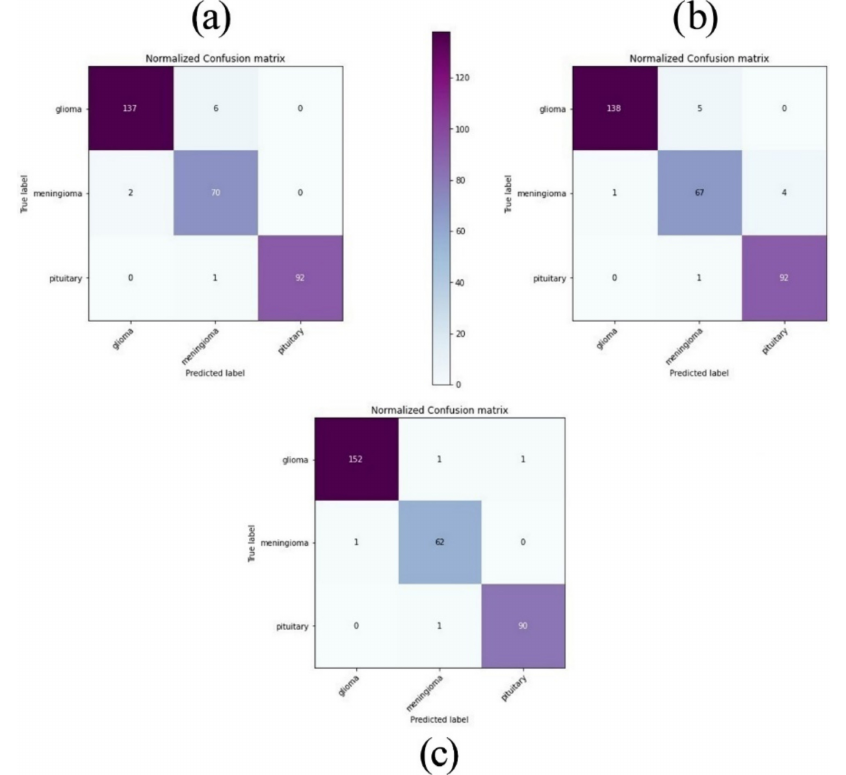
Figure 16. Confusion matrices of the optimized model, VGG16, and VGG19. ( a ) VGG16. ( b ) VGG19. ( c ) The optimized model.